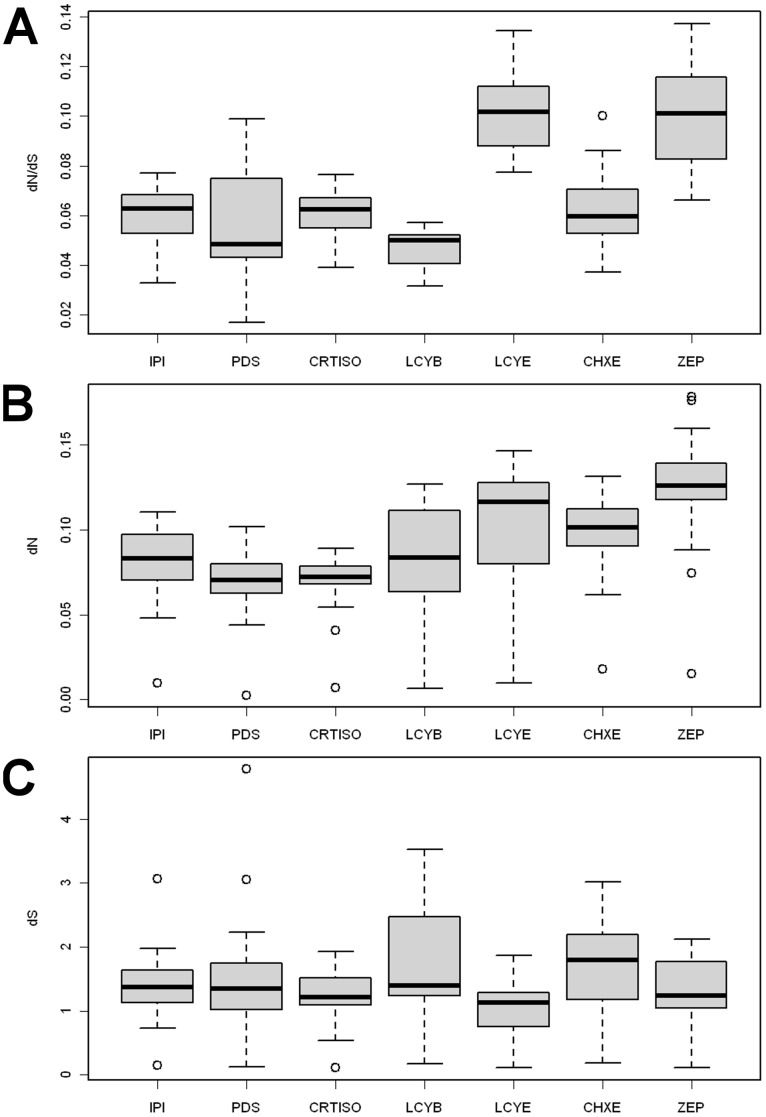
Role of nonsynonymous and synonymous substitution rates in dN/dS ratio variation.Distribution of (A) dN/dS ratio , (B) nonsynonymous substitution rate dN and (C) synonymous substitution rate dS calculated from pairwise comparison of seven dicots are displayed as a function of carotenoid biosynthesis genes. The genes are classified according to their pathway position.